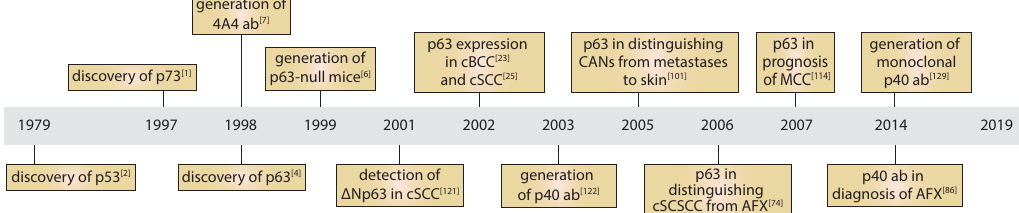
Figure 4. Timeline of important discoveries in the study of p63 in skin cancer. Since the discovery of p63 in 1998, significant progress has been achieved in understanding its role in normal epithelia as well as in cancer. In the early 2000s, multiple lines of evidence demonstrated its possible use as a diagnostic marker in excluding cutaneous spindle cell SCC (cSCSCC) and adnexal neoplasms during the diagnosis of atypical fibroxanthoma and metastases to skin, respectively. Development of the ∆ Np63-specific antibody, p40 (ab), improved the specificity of diagnosis. Moreover, p63 expression is associated with a poorer prognosis in Merkel cell carcinoma, rendering it a new predictive marker of